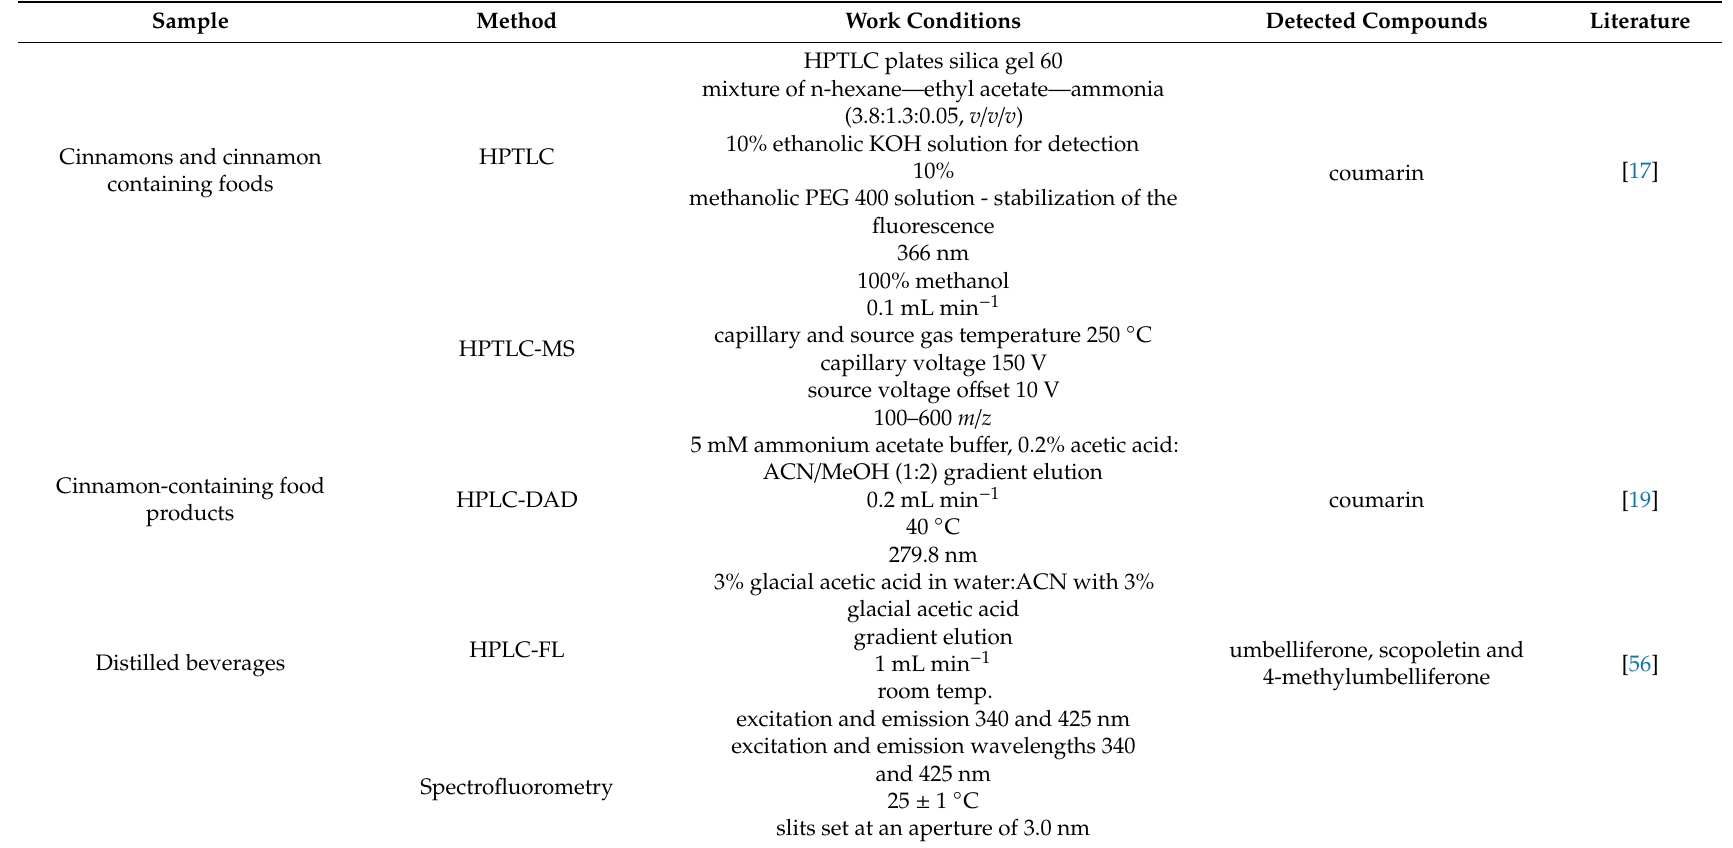
Table 6. Overview of newer methods of detection and quantification of coumarin and related